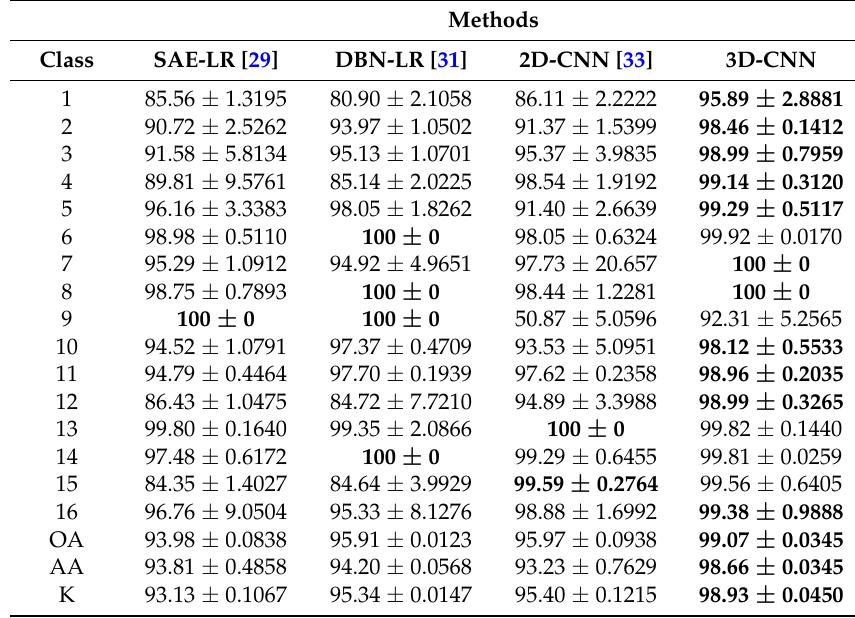
Table 9. Classification results (%) of Indian pines